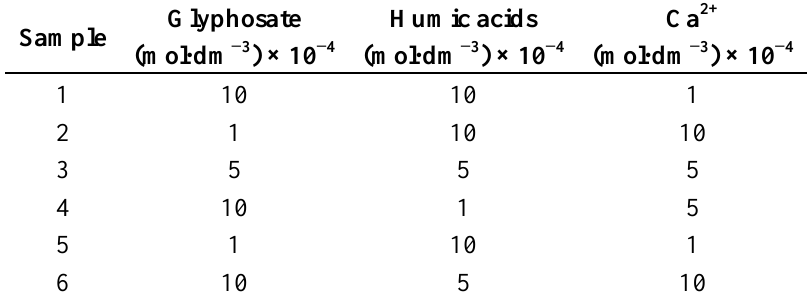
Table 1. Concentration of samples prepared by addition of three selected